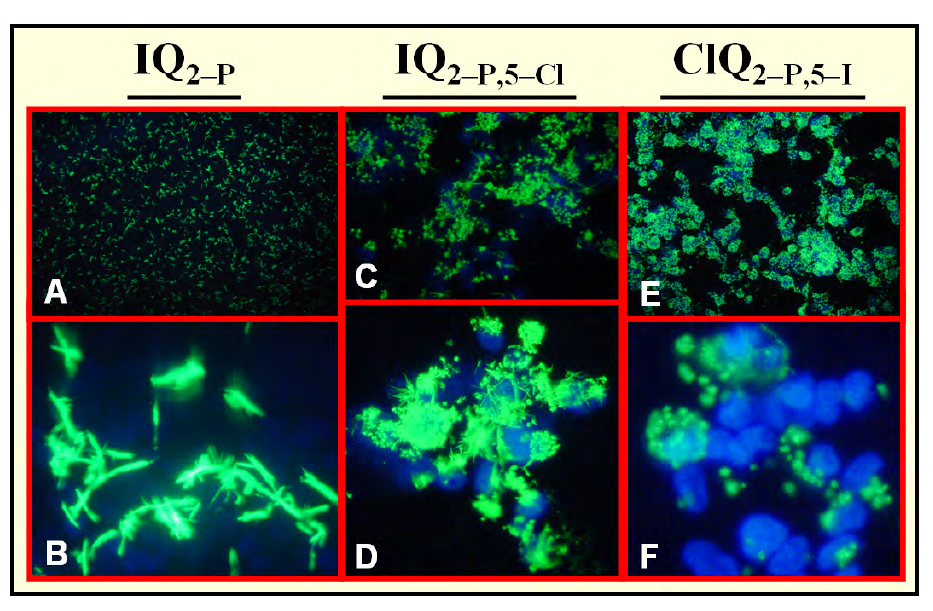
Figure 5. Fluorescence microscopy of viable human TE671 rhabdomyosarcoma cells incubated (37 o C) in vitro (pH 7.4) with IQ analogs, showing hydrolysis and 2–P crystallization of these derivatives (green). Note different size and intensity of crystals formed. (A, C, and E) low power – cells not washed. (B, D, and F) high power –cells washed with PBS, fixed in methanol, and nuclei counterstained with DAPI